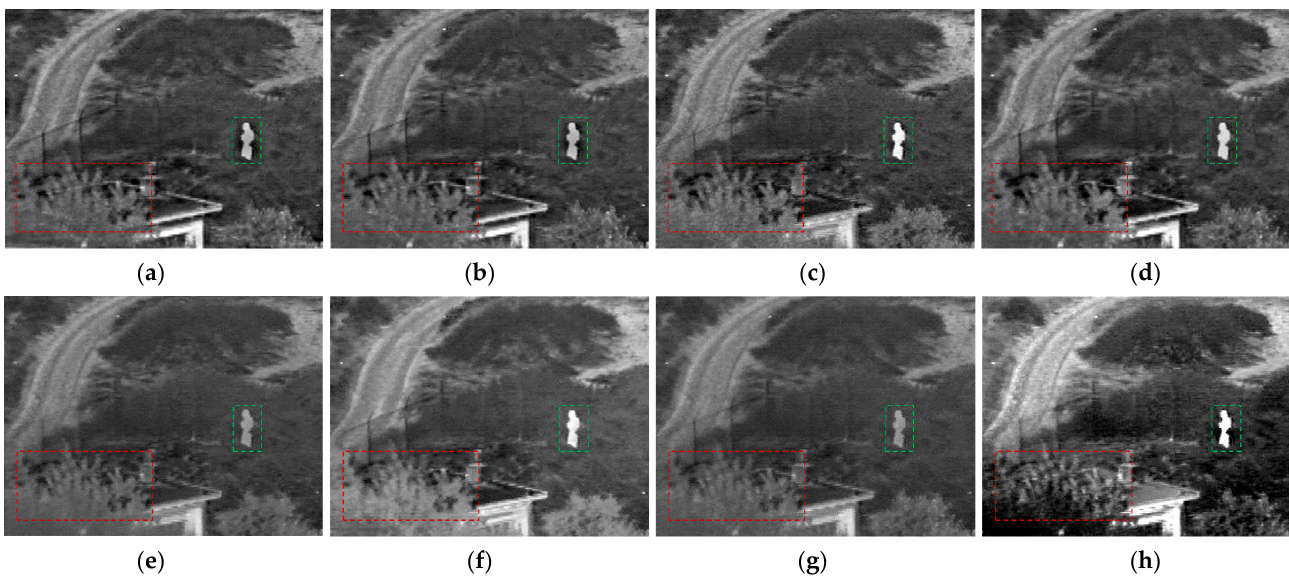
Figure 11. Performance comparison of different fusion methods on the image pair “Camp”. ( a – h ) are the results of CVT, CWT, WLS, LP, ADF, GTF, MSVD and our algorithm, respectively. the results of CVT, CWT, WLS, LP, ADF, GTF, MSVD and our algorithm,